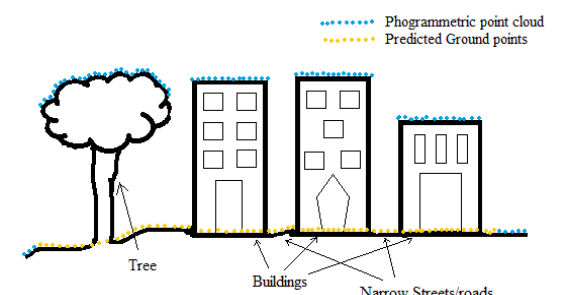
Figure 3. Pictorial representation of Photogrammetric point cloud (Blue points) and generated ground points (Yellow points).